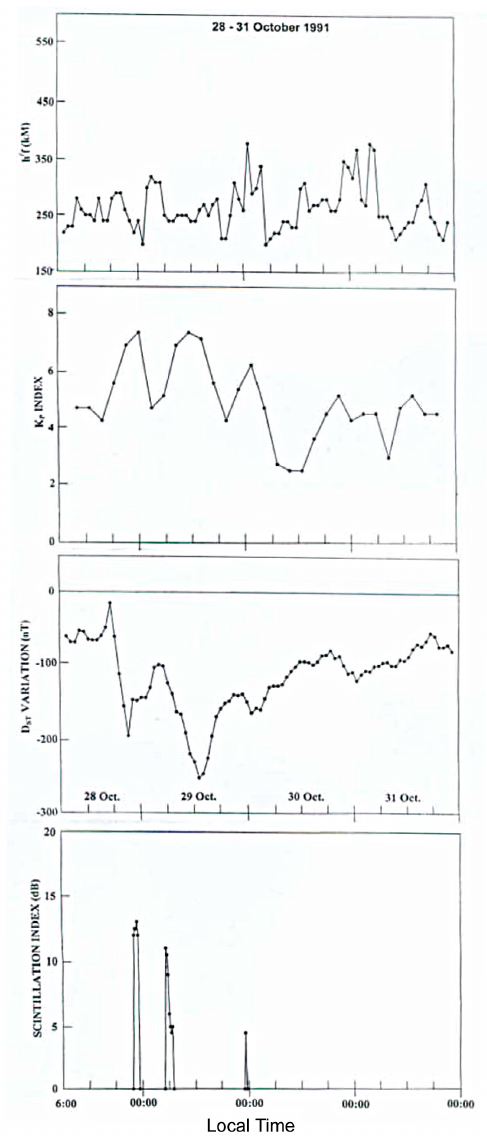
Fig. 10. Example of a magnetic storm that occurred during 28 − 31 October 1991. The top panel is ionospheric F-layer height (h 0 F) at Ahmedabad, the two middle panels are K p and D st and the bot- tom panel shows the occurrence times of scintillation activity at